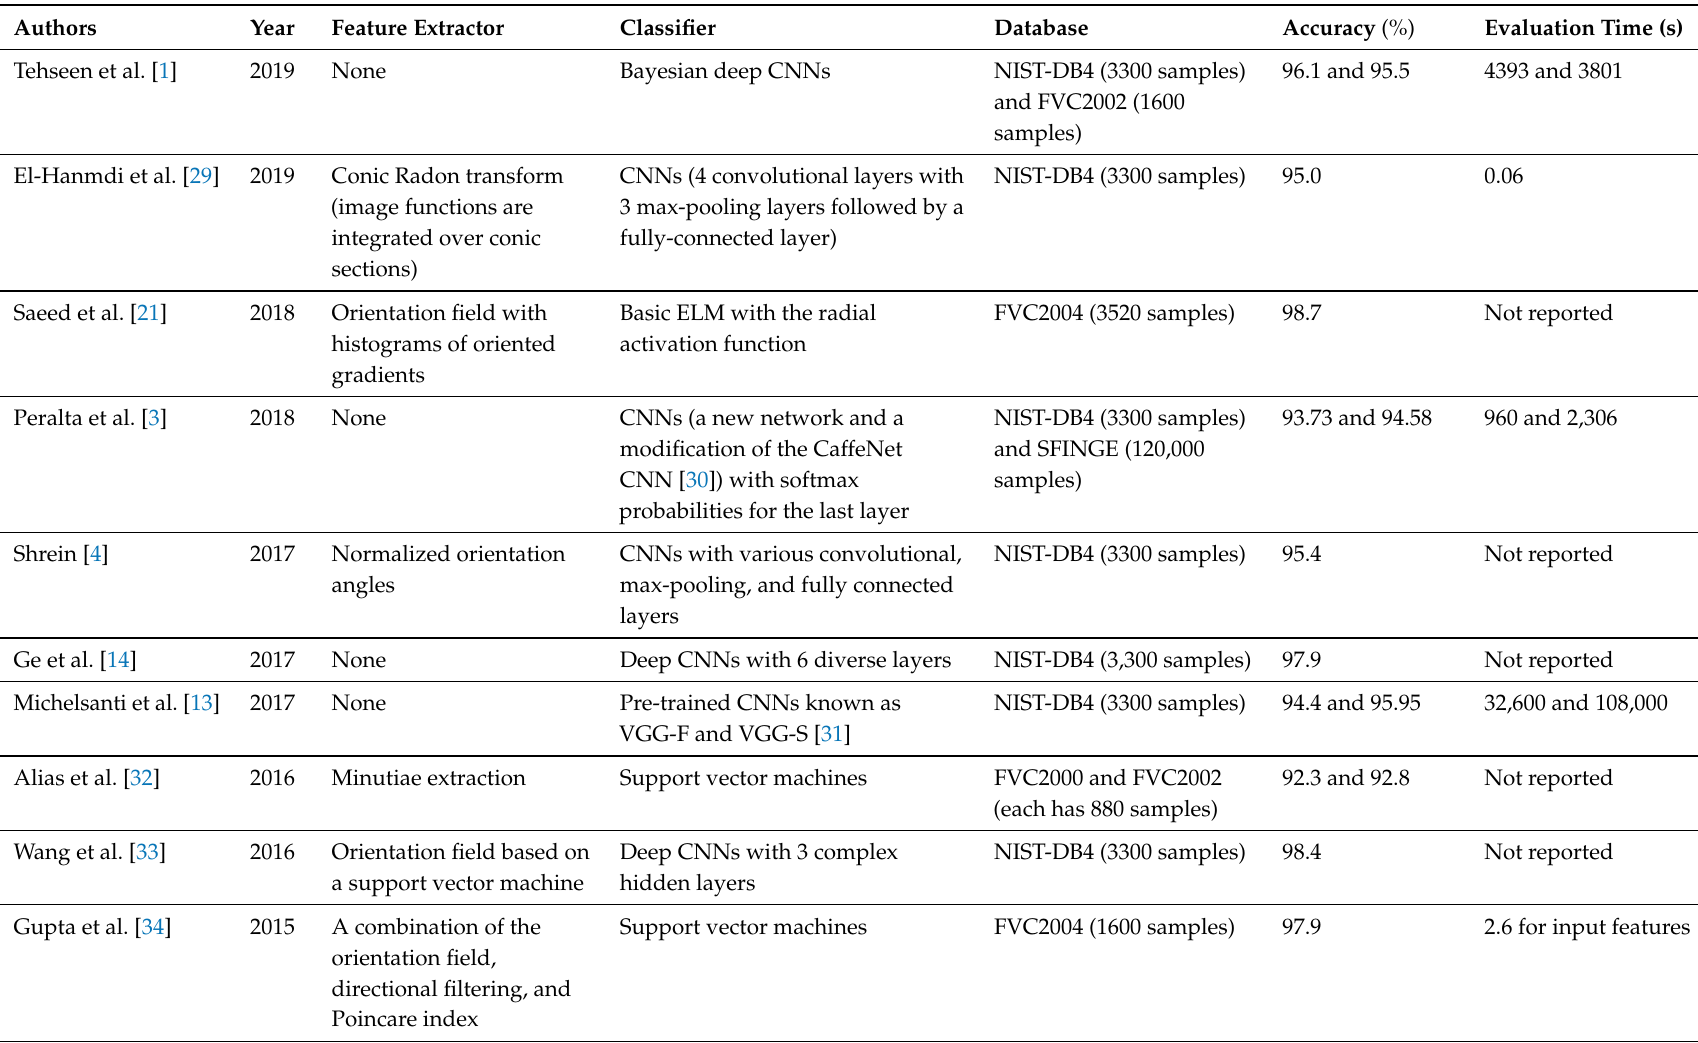
Table 1. Summary of the state-of-the-art approaches for the fingerprint classification